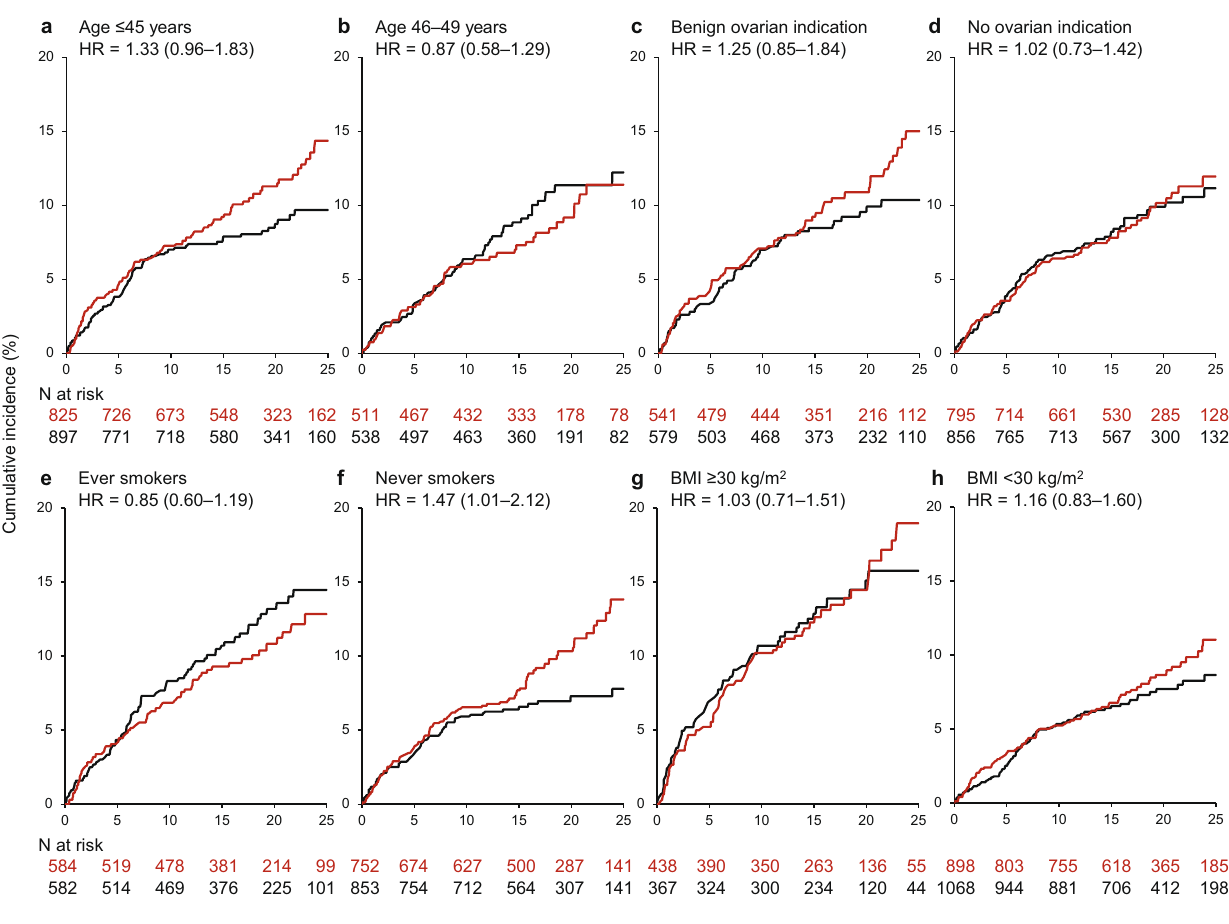
Fig. 2 Cumulative incidence curves for all asthma in women who underwent bilateral oophorectomy compared with referent women. a , b Strata by age at oophorectomy; c , d strata by surgical indication; e , f strata by smoking status; g , h strata by body mass index at index date. The curves were weighted using inverse probability weights derived from a logistic regression model including 16 chronic conditions present at index, years of education, quartiles of household income, race, body mass index, cigarette smoking, and age and calendar year at index date (details provided in text). The interaction was signi fi cant by smoking status ( P = 0.03), but not by age at oophorectomy, surgical indication, or by body mass index. BMI body mass index, HR hazard